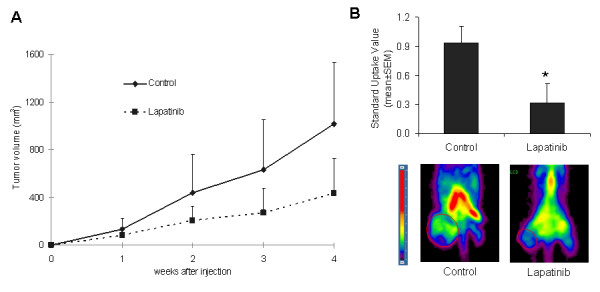
In vivo tumor growth assays. A. After tumor implantation into immunocompromised nude mice, animals were treated with lapatinib for four weeks at the indicated concentration. Tumor volumes in treated mice were smaller than those found in controls; B. Lapatinib significantly reduced tumor metabolism (P = 0.037), which was shown by the standardized glucose uptake values (SUV) measured with micro-PET.